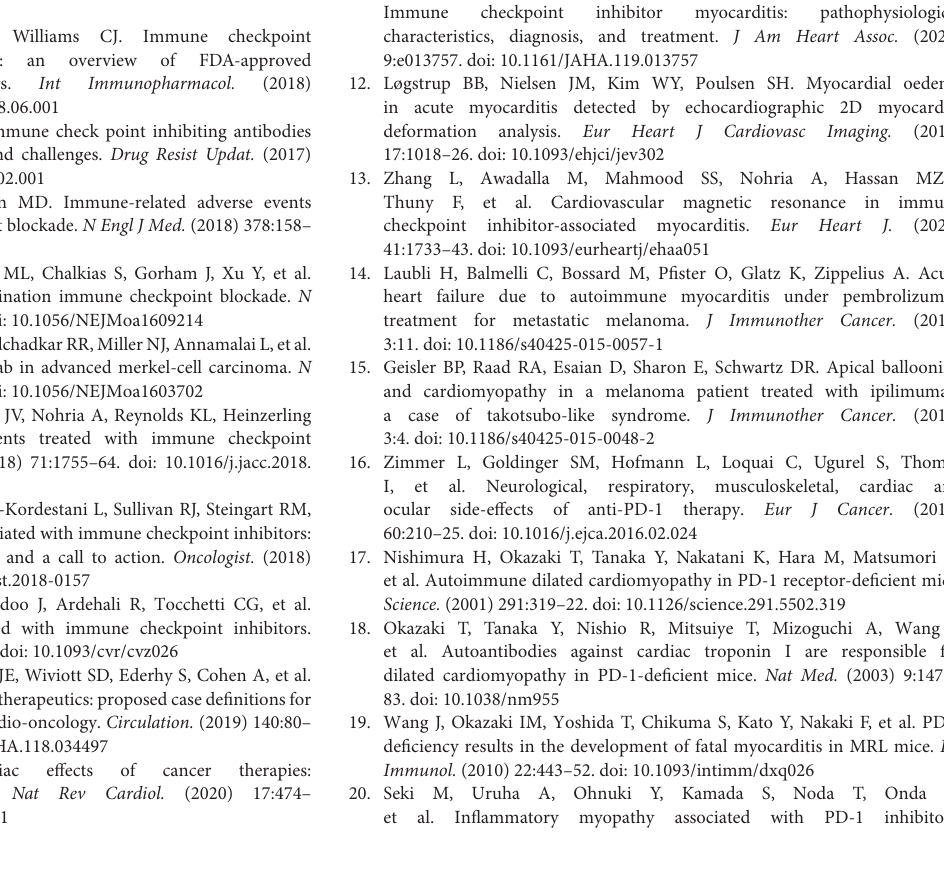
Supplementary Figure 1 | Clinical characteristics of case 1. (A) Typical electrocardiograms (ECG) of case 1: ECG on the left indicated II ◦ atrioventricular block; ECG on the right side indicated III ◦ atrioventricular block. (B) SPECT of case 1 showed extensive myocardial perfusion reduction. (C) Serum level of hsTnI and CK-MB. (D) Endomyocardial biopsy of the patient showed cardiomyocyte degeneration and mild effusion. Supplementary Figure 2 | Clinical characteristics of case 2. (A) Serum level of hsTnI and CK-MB. (B) Typical ECGs of case 2 showed sinus tachycardia on the left side and III ◦ AVB and elevation of ST segment in I and aVL on the right side. Supplementary Figure 3 | Clinical characteristics of case 3. (A) Typical electrocardiogram of case 3 showed elevated ST segment in II, III, aVF and V1-6 leads and complete right bundle branch block. (B) Serum level of hsTnI and CK-MB. (C) Typical electrocardiogram of case 3 showed complete right bundle branch